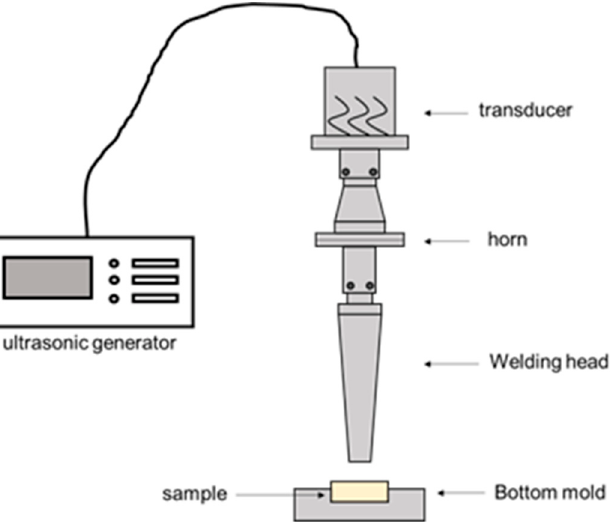
Figure 2. Schematic diagram of ultrasonic strengthening equipment .